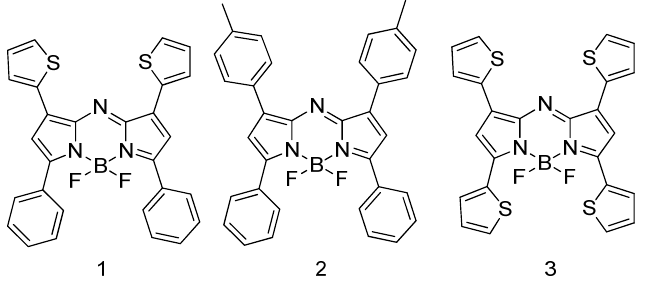
Figure 1. Structural formula of investigated aza-BODIPYs.